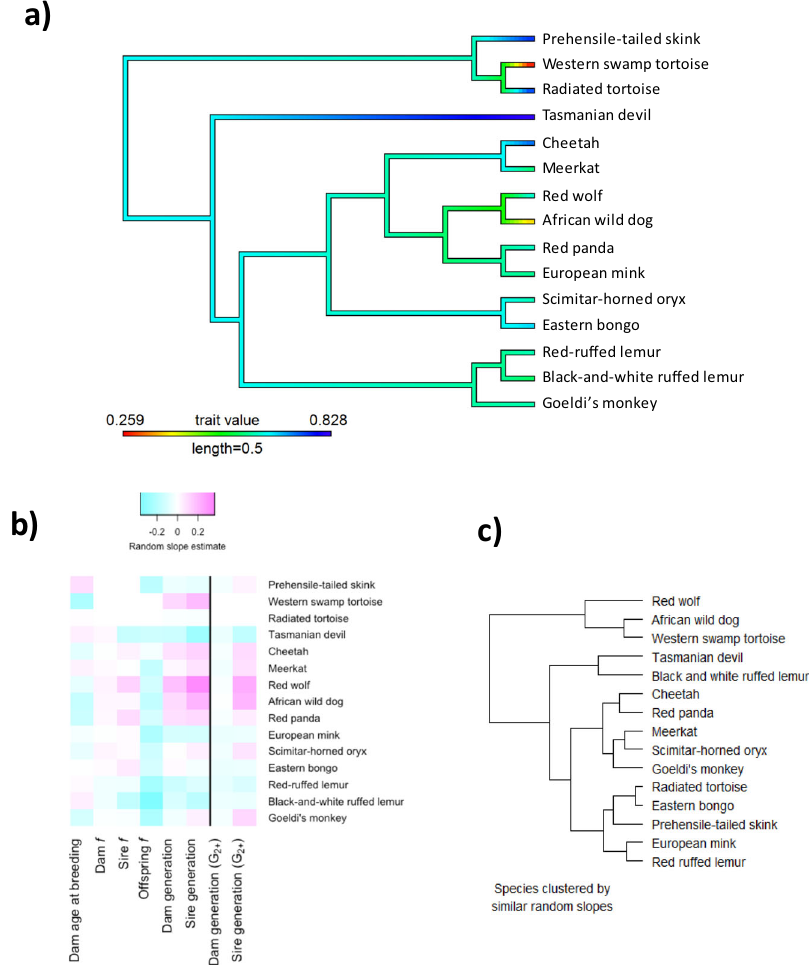
Fig. 2 Phylogeny and random slope results. a Phylogenetic relationships among the 15 species included in this study, shaded by the species ’ mean offspring survival (red = lower mean survival relative to other species in dataset, blue = higher mean survival). No evidence of phylogenetic signal was detected using this tree. b Heatmap of random slope estimates (i.e. magnitude of species-level effects of predictors on survival) for each parameter across the 15 species ( f = inbreeding coef fi cient, pink = positive relationship between parameter and offspring survival, blue = negative relationship). Note that no random slopes could be estimated for sire age at breeding. The vertical black line separates the model with all offspring from the model with G 2 + offspring (no wild-born parents) only. c Dendrogram of species clustered based on similar random slope values, not phylogenetic